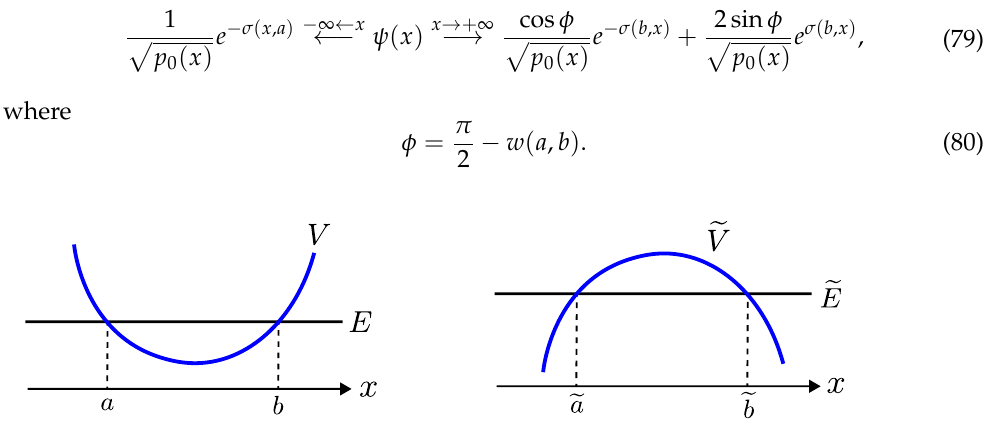
Figure 6. Two turning points in the WKB